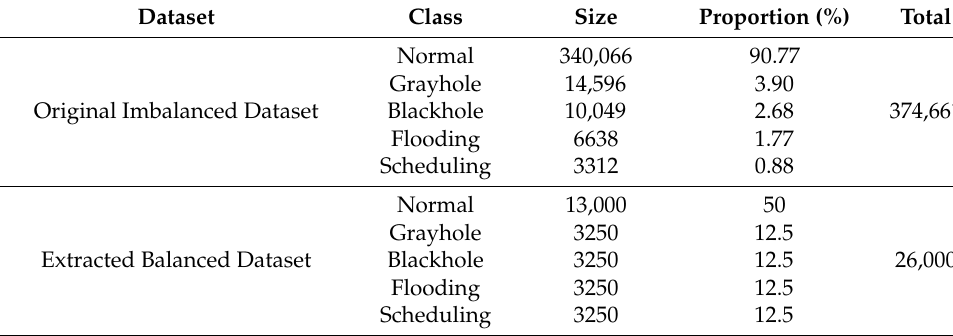
Table 1. Original and extracted balanced datasets.